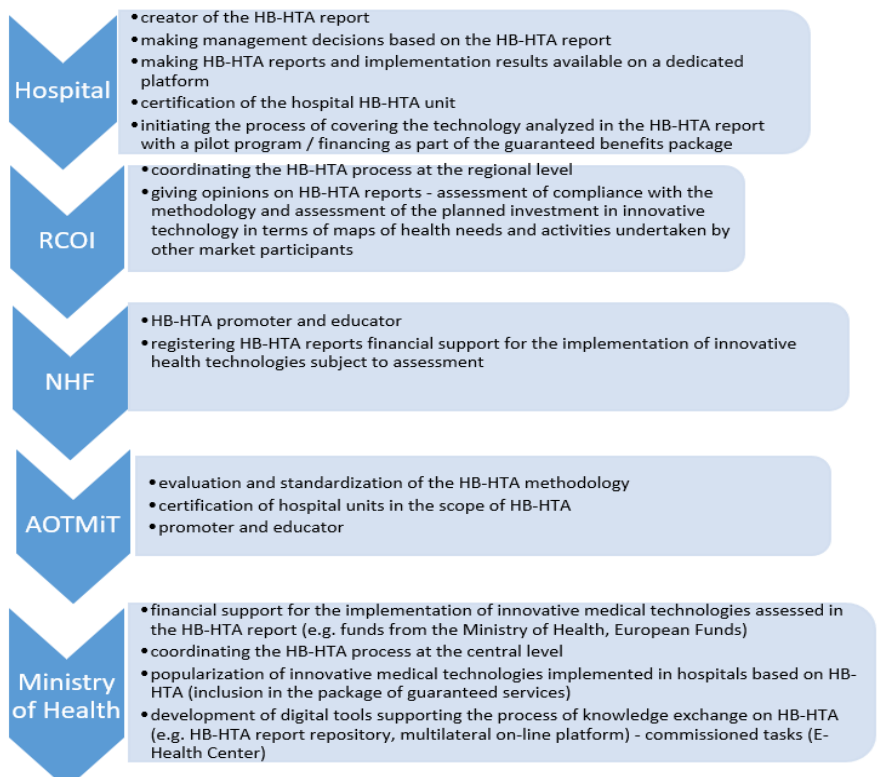
Figure 3. Roles in the HB-HTA process assigned to key entities in the functional strategic model with the coordinating role of the RCOI supported by the National Health Fund and AOTMiT (mixed model). Source: Kowalska-Bobko I. Gałązka-Sobotka M. HB-HTA functional model with the coordinating role of the Regional Center for Investment Assessment supported by the National Health Fund and the Agency for Health Technology Assessment and Tariff System mixed Health and Management” 2020; 18 (4). P. 298–309.